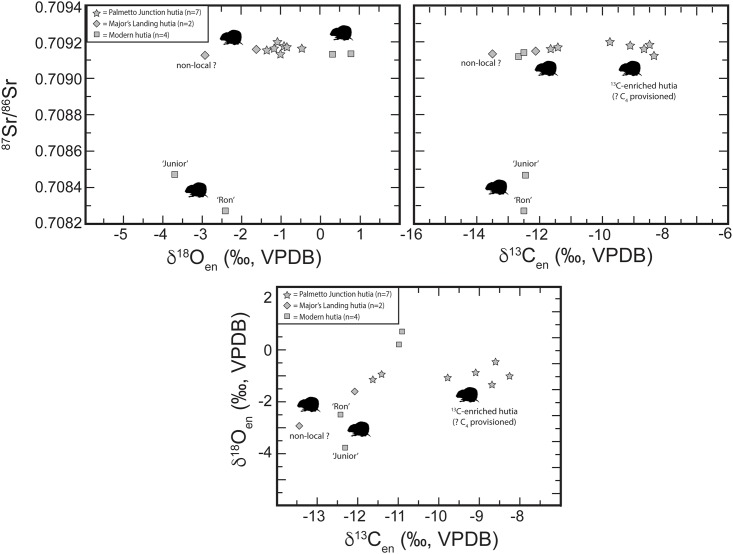
Tooth enamel isotope data for Bahamian hutias (Geocapromys ingrahami) analyzed in this study.5a) (top two boxes) Bivariate plot of δ18O and 87Sr/86Sr and δ13C and 87Sr/86Sr. 5b) (bottom box) Bivariate plot of δ13C and δ18O. Note distinct radiogenic strontium isotope values and lower δ18O for the two modern hutias, ‘Junior’ (FLMNH 22383) and ‘Ron’ (FLMNH 22385), translocated to Gainesville, Florida. The ‘non-local?’ Crooked Island individual sampled (BCL# 2811) exhibits lower δ18O and δ13C values, which suggests it was subject to a different feeding regime compared to other zooarchaeological Bahamian hutias sampled.